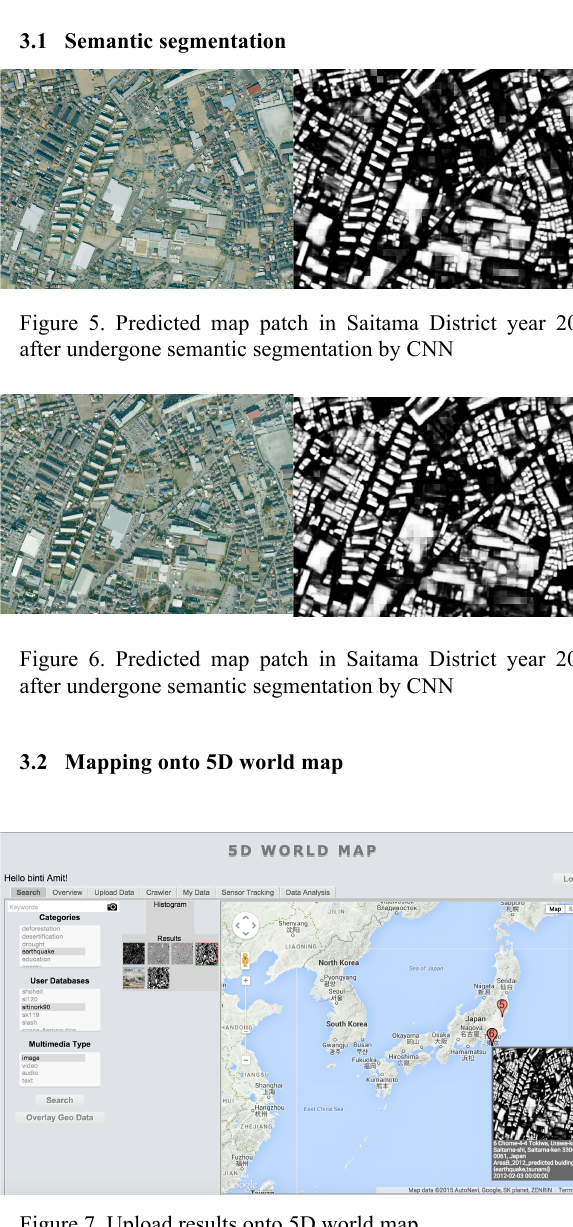
Figure 7. Upload results onto 5D world map